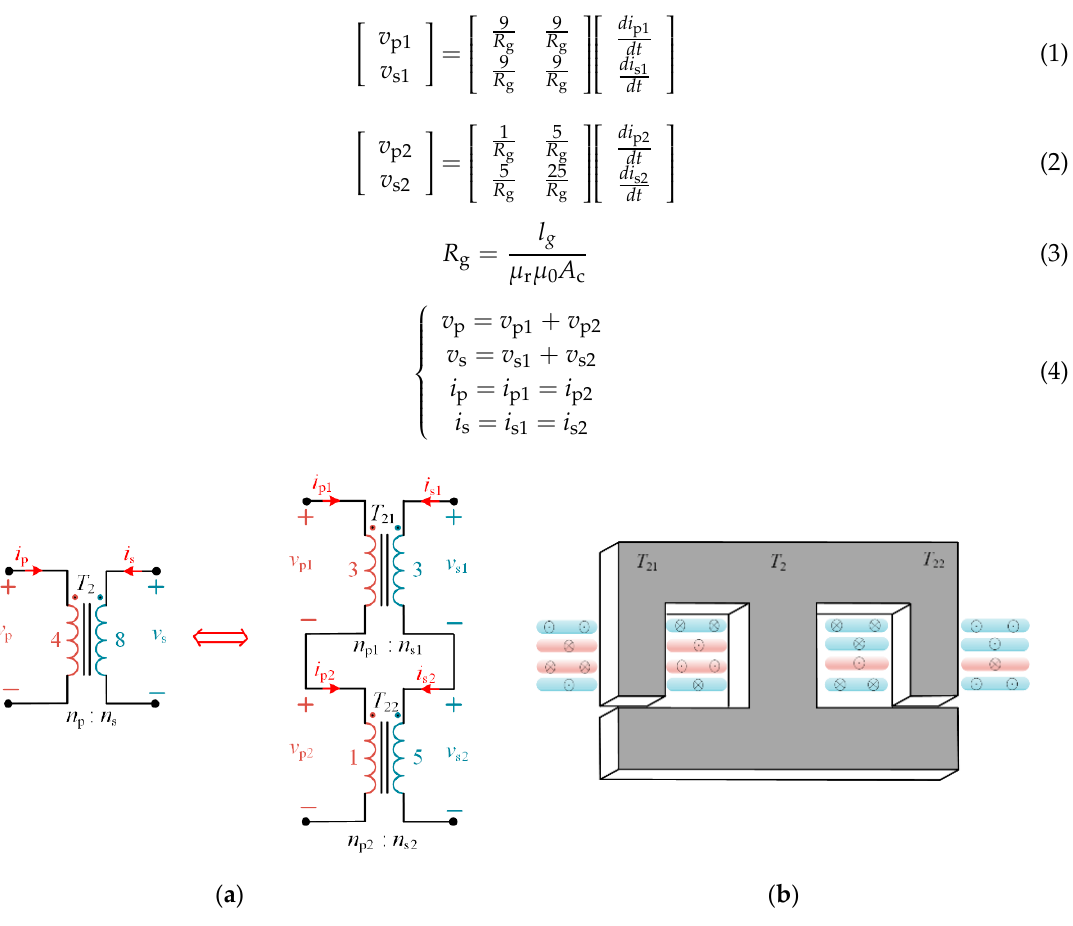
Figure 3. Equivalent winding connection way and EI (E-type and I-type) core structure of T 2 ( a ) equivalent connection way of T 2 , ( b ) EI core structure of T 2 .